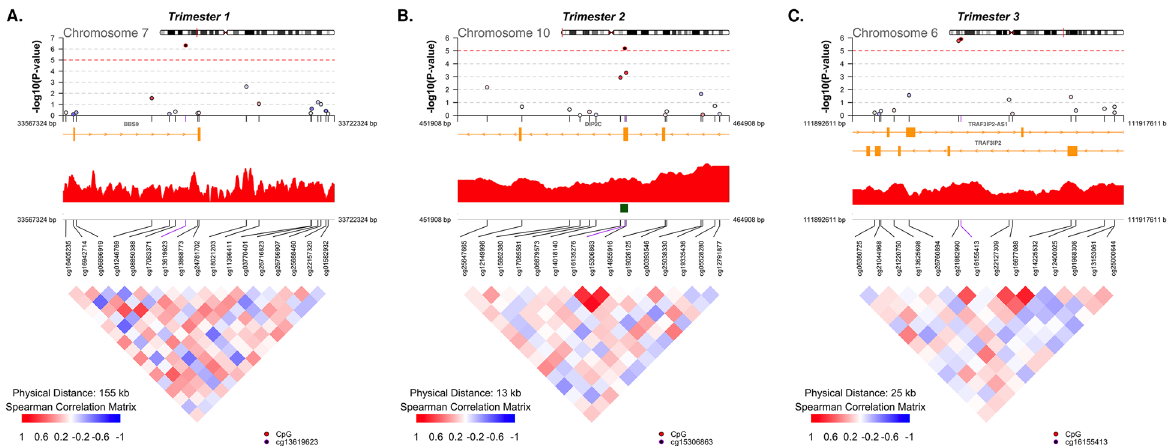
Fig. 2 Comet plots of the top CpGs for trimesters 1, 2, and 3. The upper panel of each comet plot shows the EWAS associations with -log 10 ( p value) on the y -axis and CpG position on the x -axis; the middle panel depicts annotation tracks, including gene (yellow), GC content (red), and CpG islands (green); the lower panel shows the beta value correlation matrix between the selected CpGs. A For trimester 1, a window of length of 15,500 bp on chromosome 7 centered by the top CpG is shown. B For trimester 2, there were 15 CpGs within the window of 13,000 bp on chromosome 10 centered by the top CpG. C For trimester 3, the window of 25,000 bp on chromosome 6 centered by the top CpG shows 14 CpGs in this